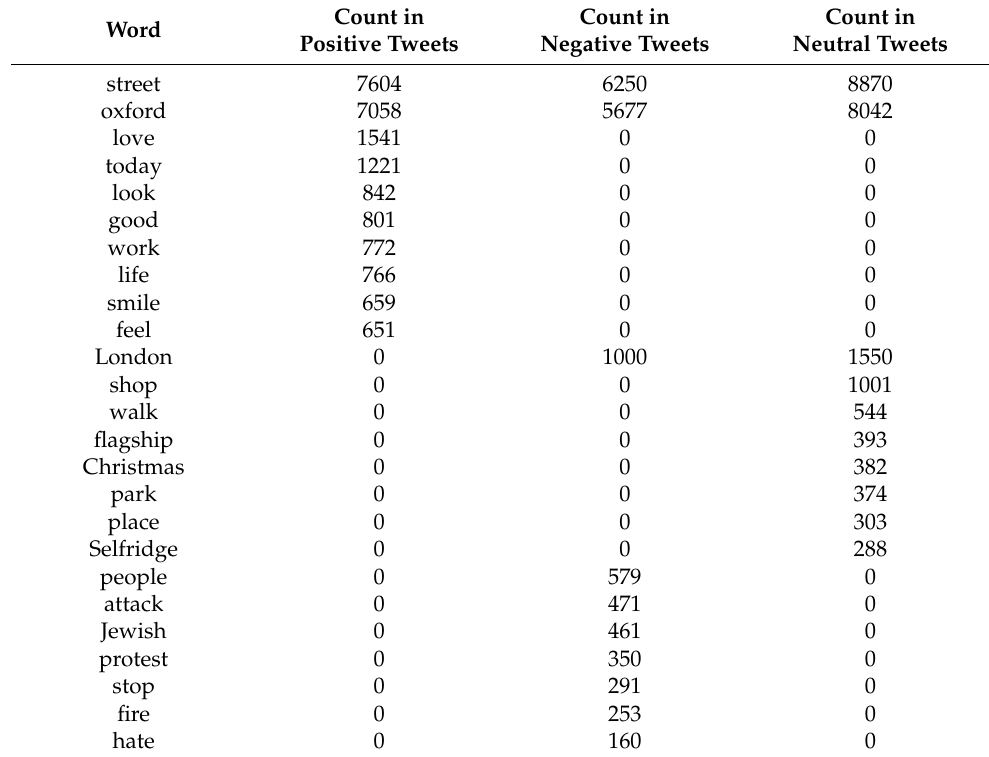
Table 2. Most frequently used words in tweets with positive, negative, or neutral sentiment.